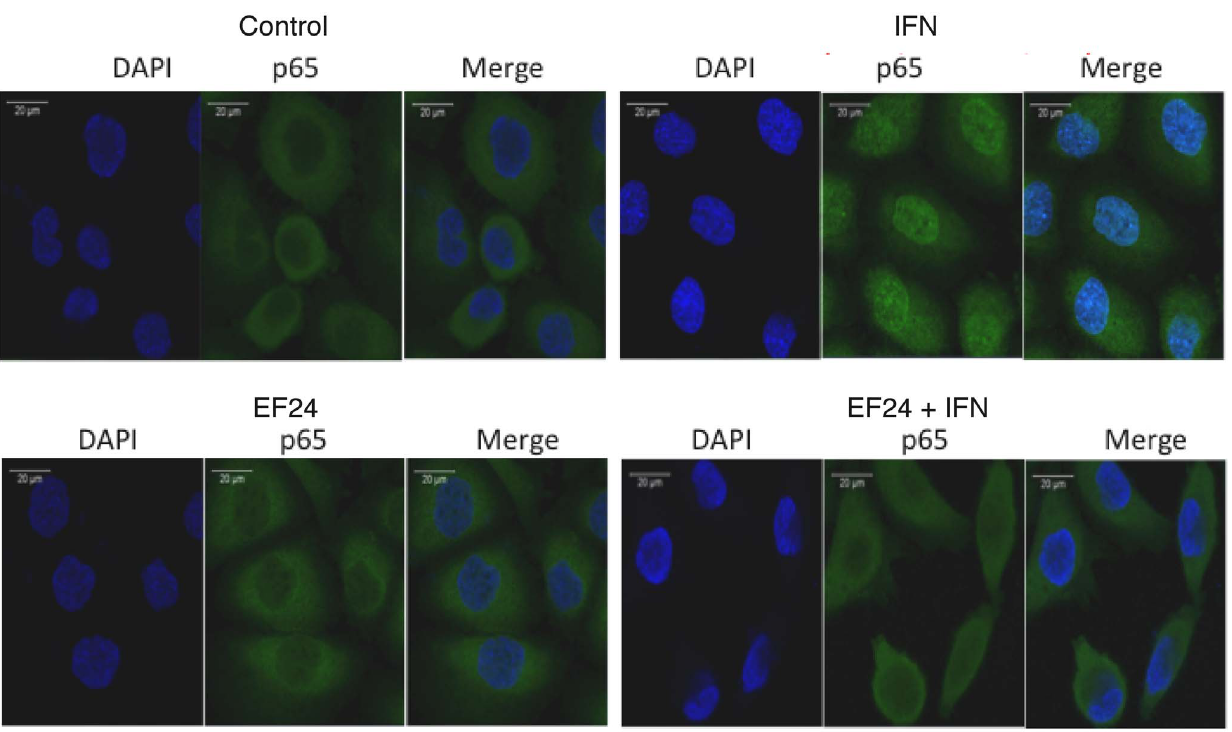
Figure 3. The effects of EF24 on activation of the p65 subunit of NF- k B in DU145 cells invitro . DU145 cells plated on 8-well chamber slides were treated with EF24 (5 m M) or vehicle (control) for 24 hr prior to stimulation with human IFN a (1000 IU/ml) for 30 min. Cells were fixed with 4% paraformaldehyde and methanol, and permeabilized with 1% Triton X100. After blocking with 5% goat serum, slides were stained for p65 and mounted using Vectashield medium with DAPI, and images were captured on a Zeiss LSM700 laser scanning confocal microscope. the NF- k B pathway in cancer cells, but does not affect STAT1 or STAT3 activation.